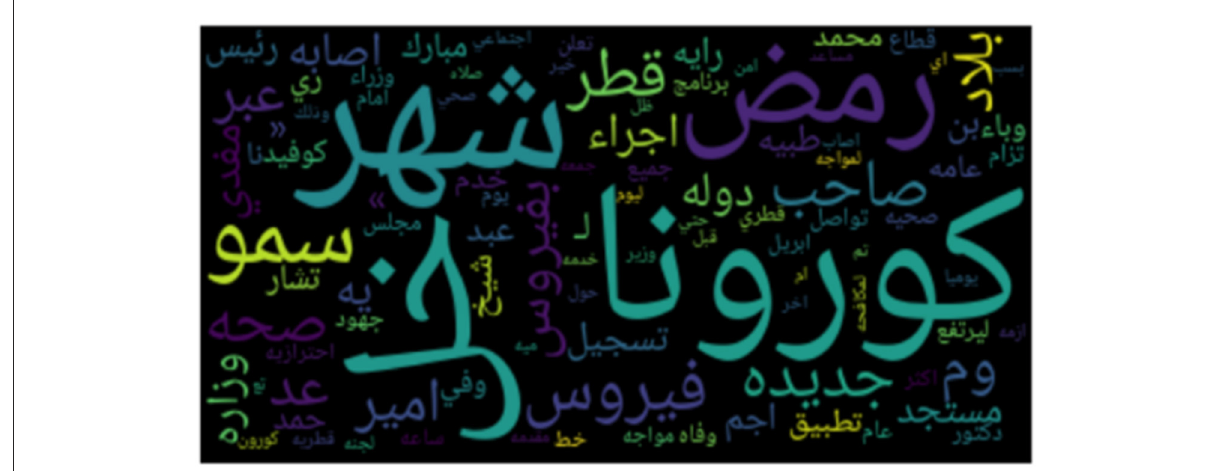
FIGURE5 Word cloud of tweets from Qatar.